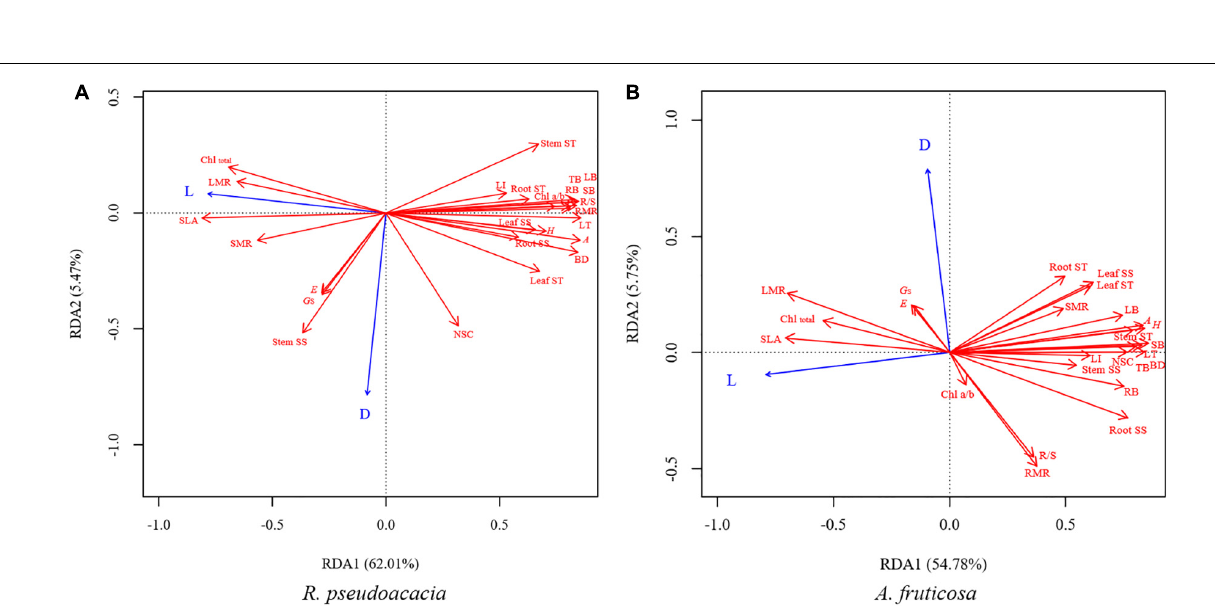
FIGURE 8 | Redundancy analysis (RDA) of the effects of light treatments (L) and defoliation (D) on plant traits of R. pseudoacacia (A) and A. fruticosa (B) after treatment for 70 days. H , height; BD, basal diameter; TB, total biomass; LB, leaf biomass; SB, stem biomass; RB, root biomass; LMR, leaf mass ratio; SMR, stem mass ratio; RMR, root mass ratio; R/S, root-shoot ratio; SLA, specific leaf area; A , the maximum photosynthetic rate; E , transpiration rate; G s , stomatal conductance; Chl total , total chlorophyll concentration; Chl a/b , Chlorophyll a/b ; LT, leaf thickness; LI, leaf lignin concentration; Leaf SS, leaf soluble sugar concentration; Stem SS, stem soluble sugar concentration; Root SS, root soluble sugar concentration; Leaf ST, leaf starch concentration; Stem ST, stem starch concentration; Root ST, root starch concentration; NSC, non-structural carbohydrates